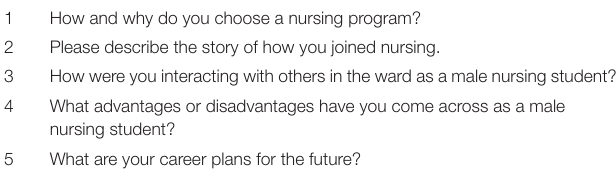
TABLE 5 | Main themes and sub-themes categorized from the